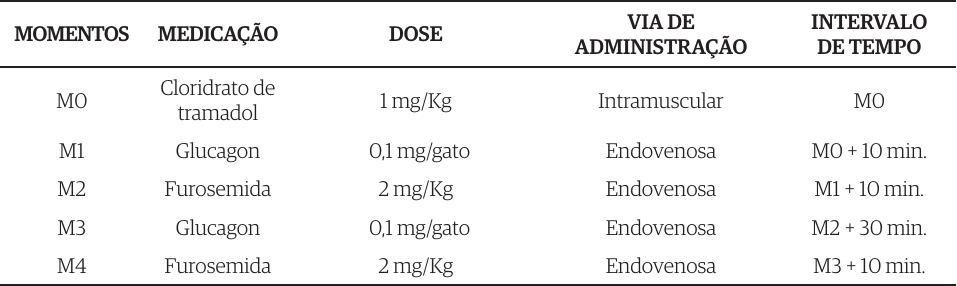
Tabela 1. Protocolo terapêutico utilizado no manjeto de obstrução